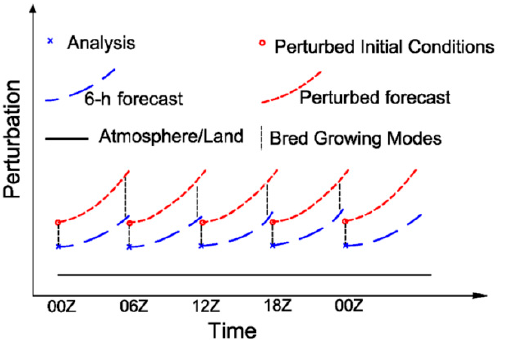
Figure 2. A schematic diagram for perturbing atmospheric and land surface variables in the breeding process.